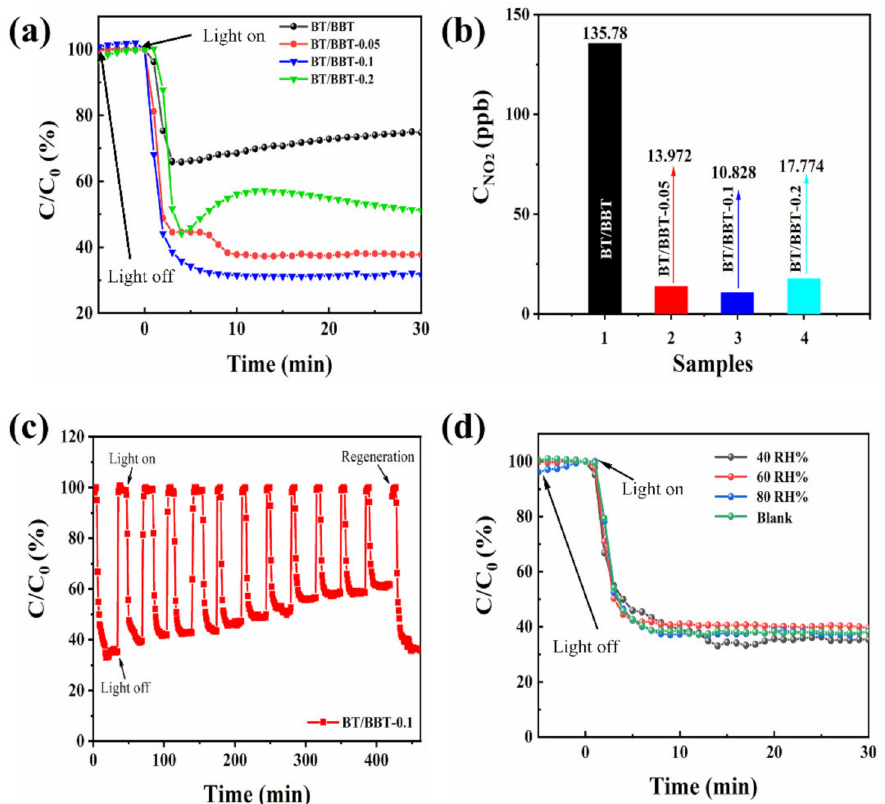
Figure 1. ( a ) Photocatalytic activity of BT/BBT, BT/BBT-0.05, BT/BBT-0.1, and BT/BBT-0.2 under visible light, ( b ) NO 2 concentration of visible light illumination, ( c ) ten cycles of photocatalytic activity of BT/BBT-0.1 and the regeneration of photocatalytic activity by rinsed with water, ( d ) effect of relative humidity on photocatalytic activity of